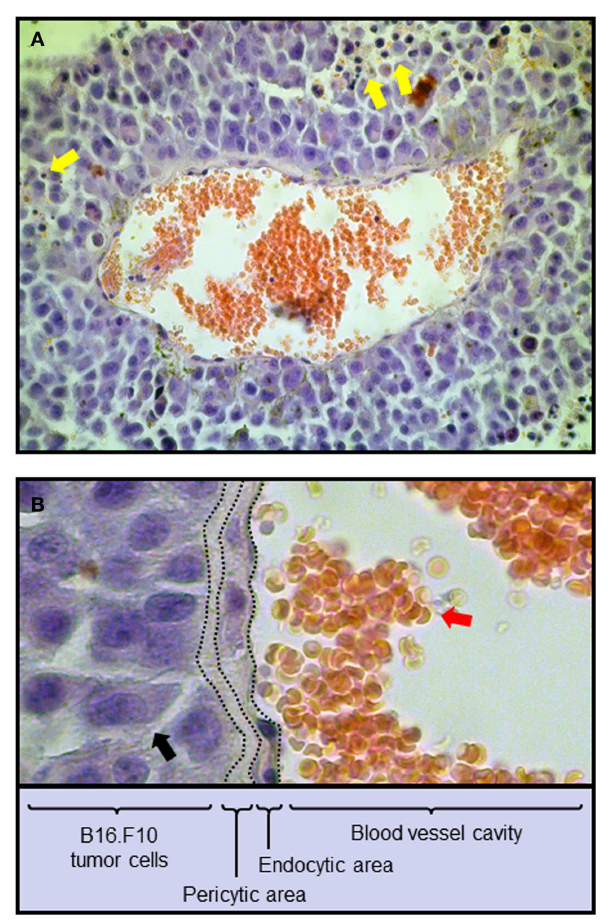
FIGURE 1 | Composition of the tumor microenvironment from a mouse melanoma tumor. C57BL/6 mice were injected subcutaneously with 0.75 × 10 6 B16.F10 melanoma cells. After 14days tumors were excised and sections stained with the Hematoxylin/Eosin method. (A) 40 × Magnification. Blood vessel with red blood cells (red circular cells) is shown. (B) Detail of the blood vessel depicted in (A) with the indication of the various functional structures linking blood vessel and tumor milieu. Yellow arrows, tumor-infiltrating leukocytes; red arrows, red blood cells; black arrows, melanoma